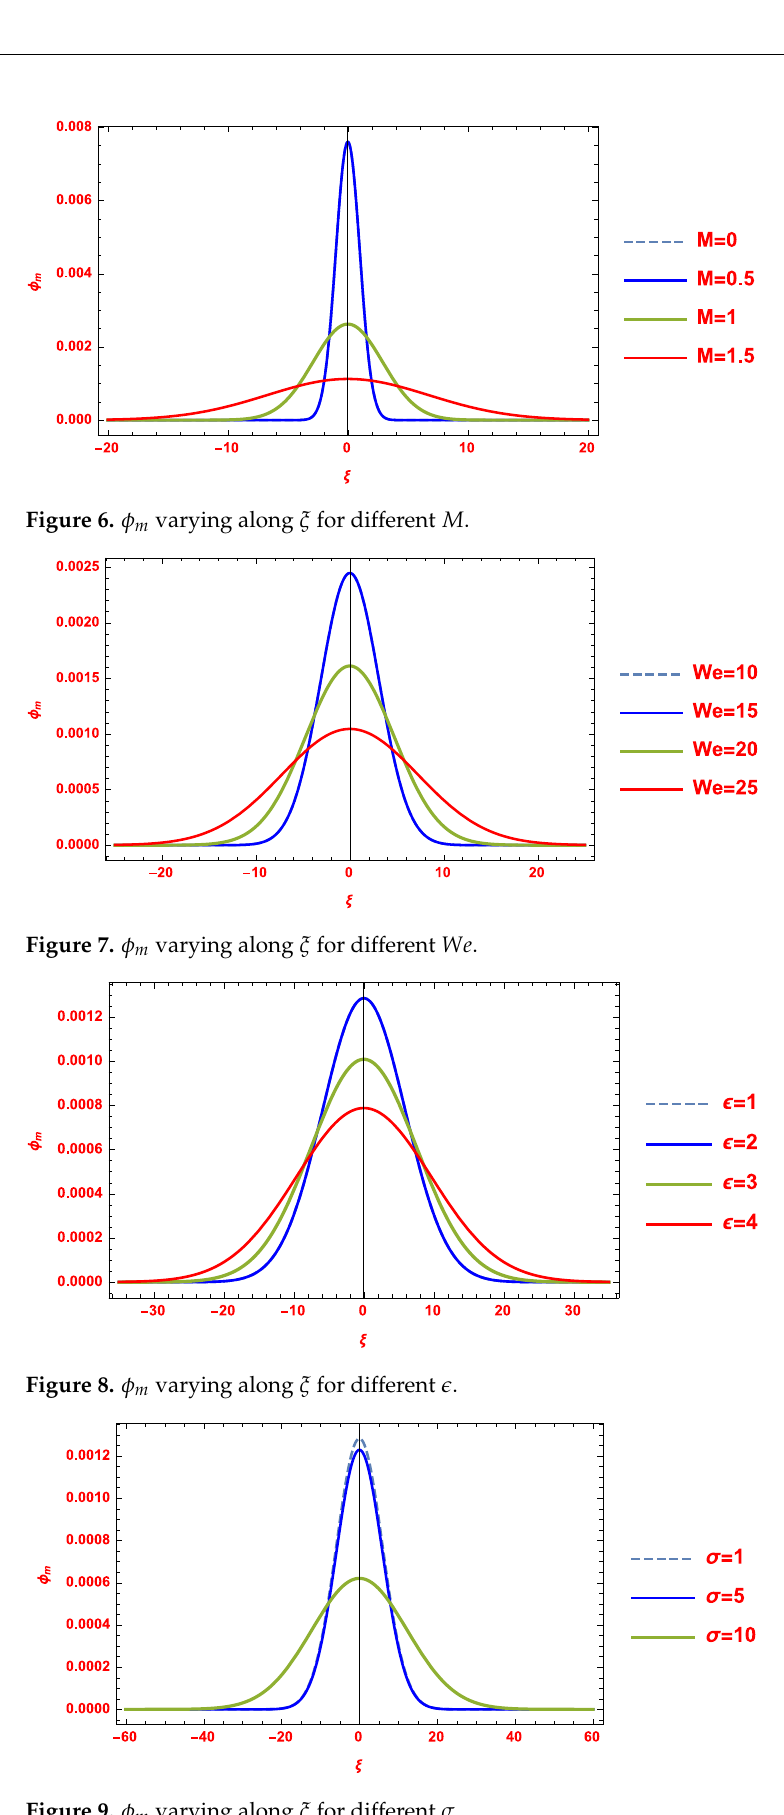
Figure 9. φ m varying along ξ for different σ